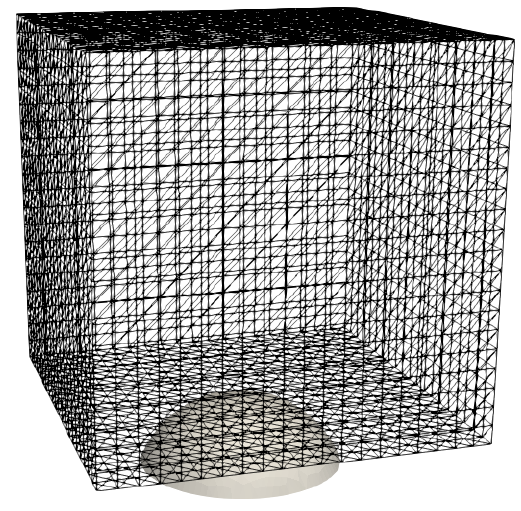
Figure 4. Cube: initial